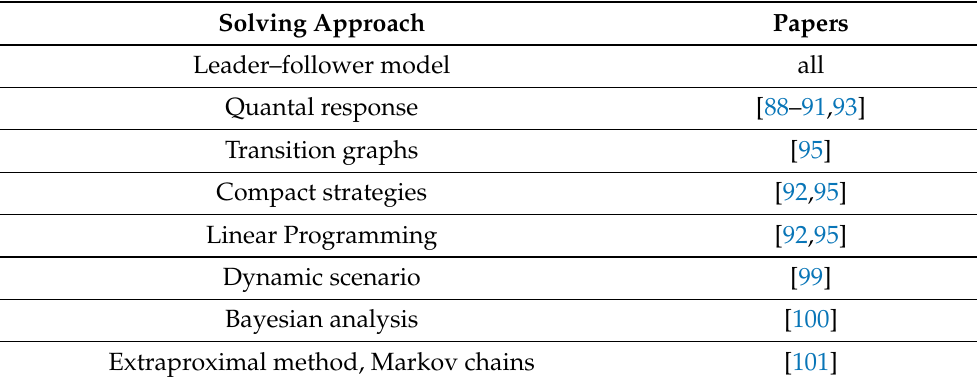
Table 5. Approaches to solving patrolling games and papers which use